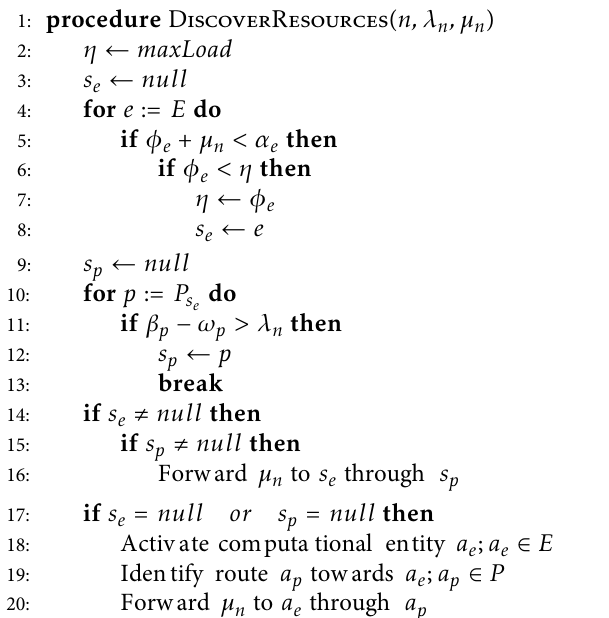
Algorithm 1 Resource discov ery